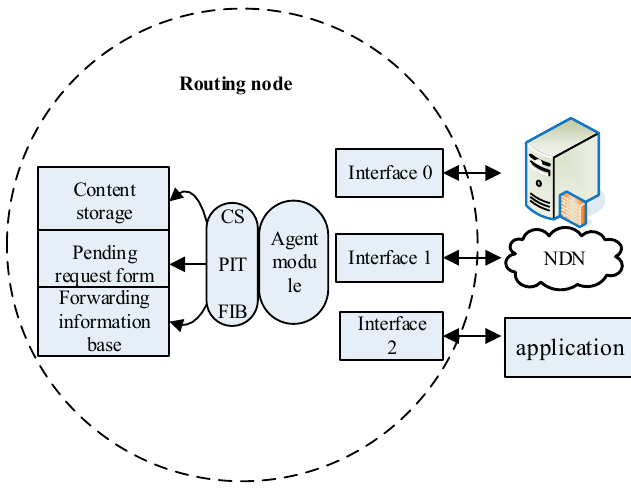
Figure 4. Relationship between NDN routers and proxy servers and applications.